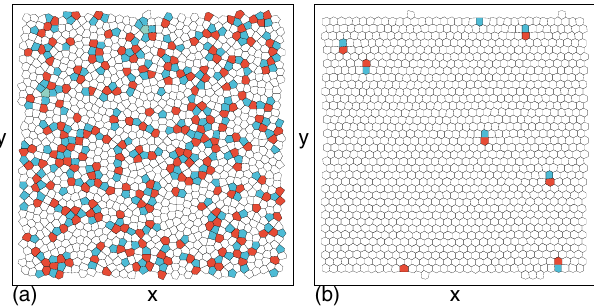
Fig. 2 Vortex con fi gurations on either side of the dynamical phase transition. Voronoi constructions of snapshots of the vortex positions in the system from Fig. 1 with vortex density n v = 1.0, pining density n p = 0.5, pinning force F p = 0.4, pinning radius r p = 0.3, and quench time t = 7.5 × 10 6 . White polygons are sixfold coordinated, red polygons are q sevenfold coordinated, and blue polygons are fi vefold coordinated. a A driving force of F D = 0.1 in the disordered phase with numerous defects. ( b ) F = 1.5 in the dynamically ordered phase. The vortex lattice is aligned in D the driving direction and there is a small number of aligned